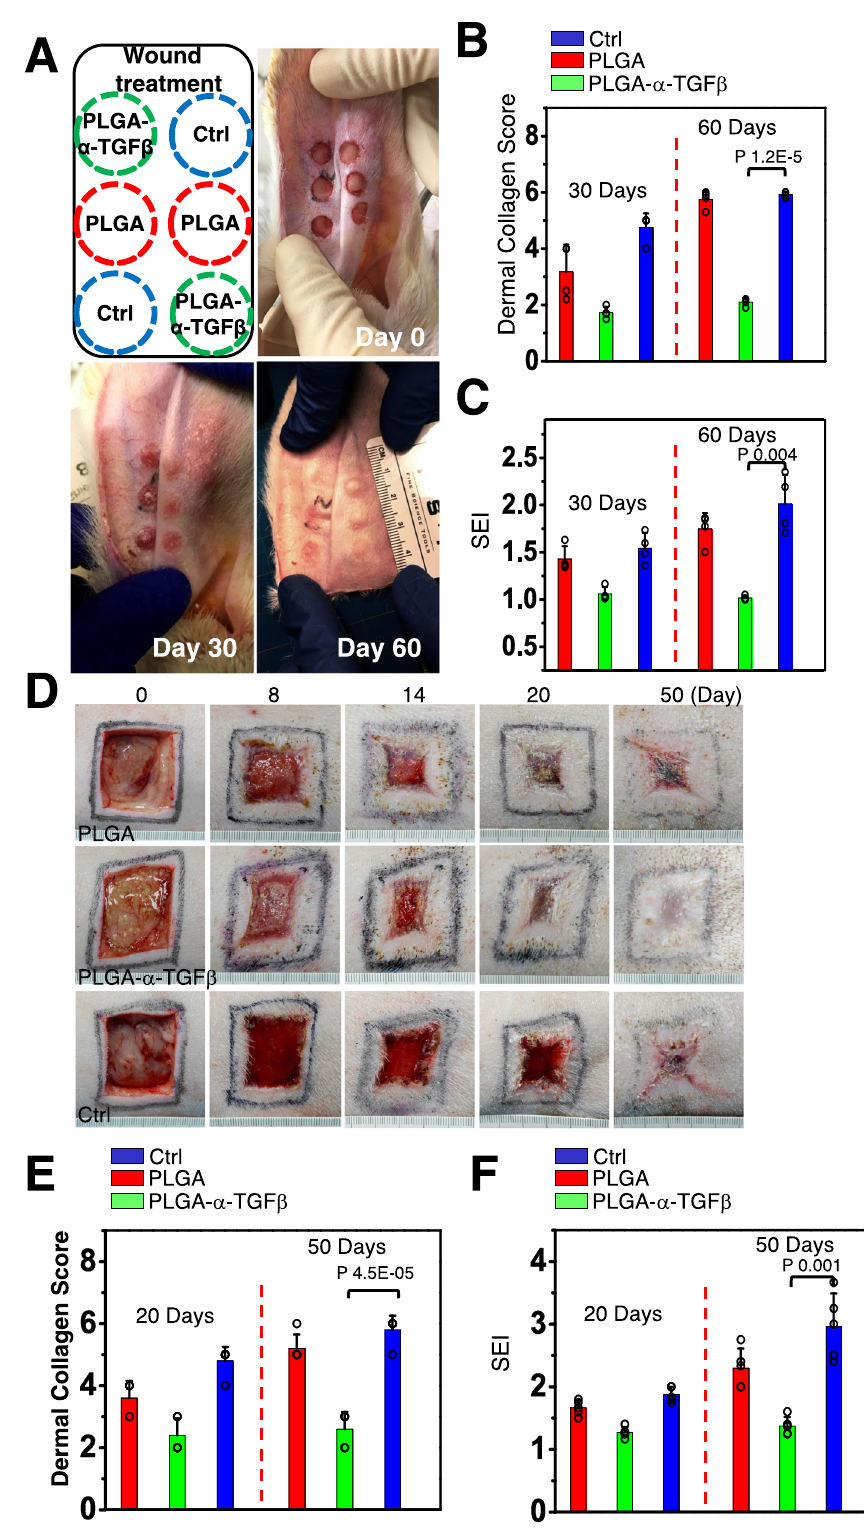
Fig. 6 PLGA-NB delivery platform can promote scarless wound healing in rabbit and porcine skin wound healing model. A Representative images of rabbit ear skin wound healing and scar formation in differently treated groups. Left upper panel shows the respective treatment for each wound on the ear. B , C Quanti fi cation of collagen deposition and SEI (scar elevation index) at different time points after wounding. n = 4 independent samples. Data are presented as mean ± SD. All error bars represent SD. p values for representative data are shown (One-tailed paired Student ’ s t-test). D Representative images of porcine skin wound healing and scar formation in differently treated groups. E , F Quanti fi cation of collagen deposition and SEI (scar elevation index) at different time points after wounding. n = 5 independent samples. Data are presented as mean ± SD. p values for representative data are shown (One-tailed paired Student ’ s t-test). All error bars represent SD. Source data are provided as a Source Data fi le.